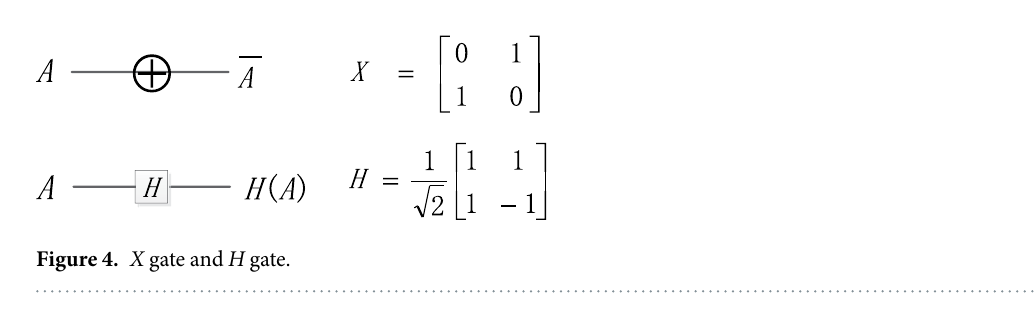
Figure 3. Bilinear interpolation method.